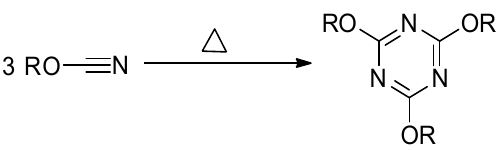
Figure 4. Scheme of cyclotrimerization of cyanate ester.